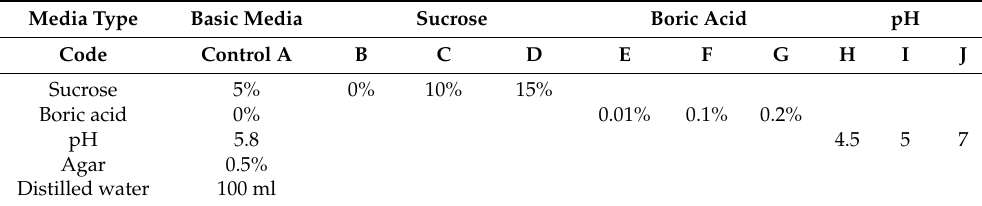
Table 1. The media used for in vitro pollen germination and pollen tube